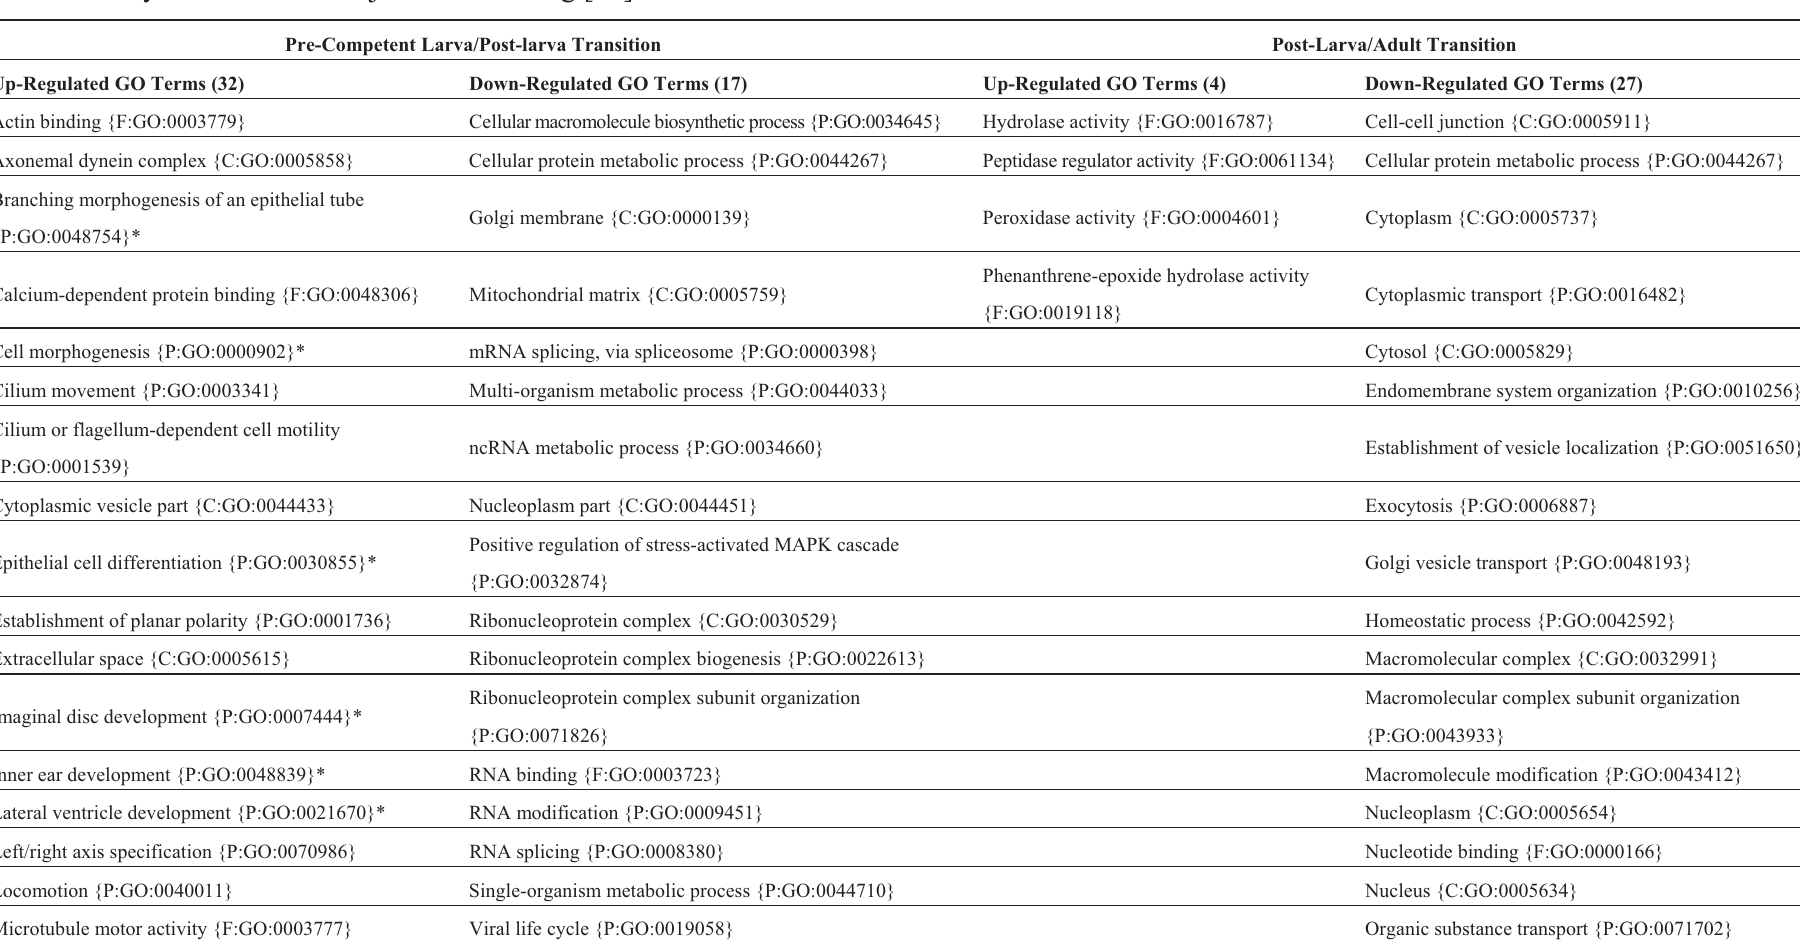
Table 3. Gene ontology terms with significantly up- or down-regulated gene groups during the two life cycle transitions. These significant GO terms are for the subsets of 1025 and 716 annotated contigs in Figure 5A with a (cid:2)4-fold expression change during the pre-competent larva/post-larva and post-larva/adult transitions, respectively. Enrichment tests of the GO terms are performed for the two life cycle transitions with the reference distribution for all stages and with Fisher’s exact test after correcting the significance level ((cid:5) = 0.05) for the false discovery rate with the Benjamini-Hochberg [79]